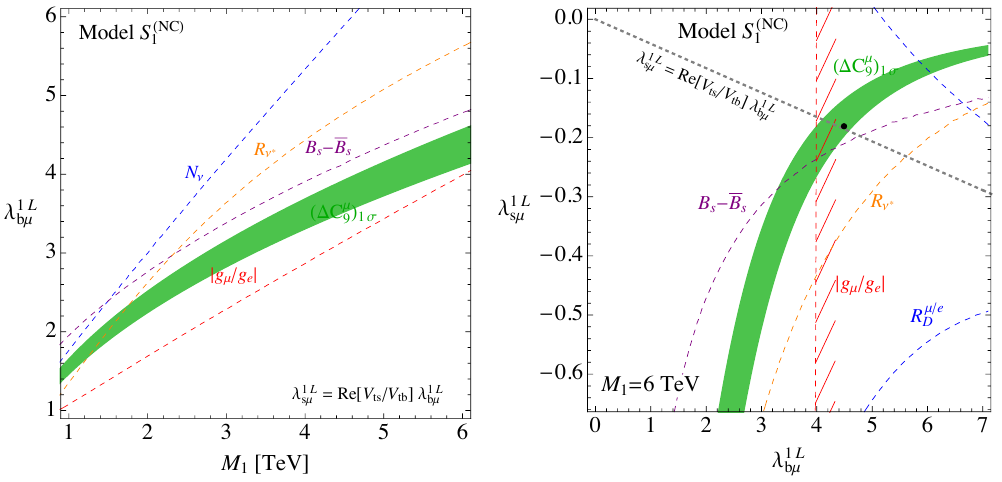
Figure 2 . Left: 95% CL limits in the plane of λ 1 L CL limits from individual observables in the plane of λ 1 L the green region is the 1 σ favourite one from ∆ C µ